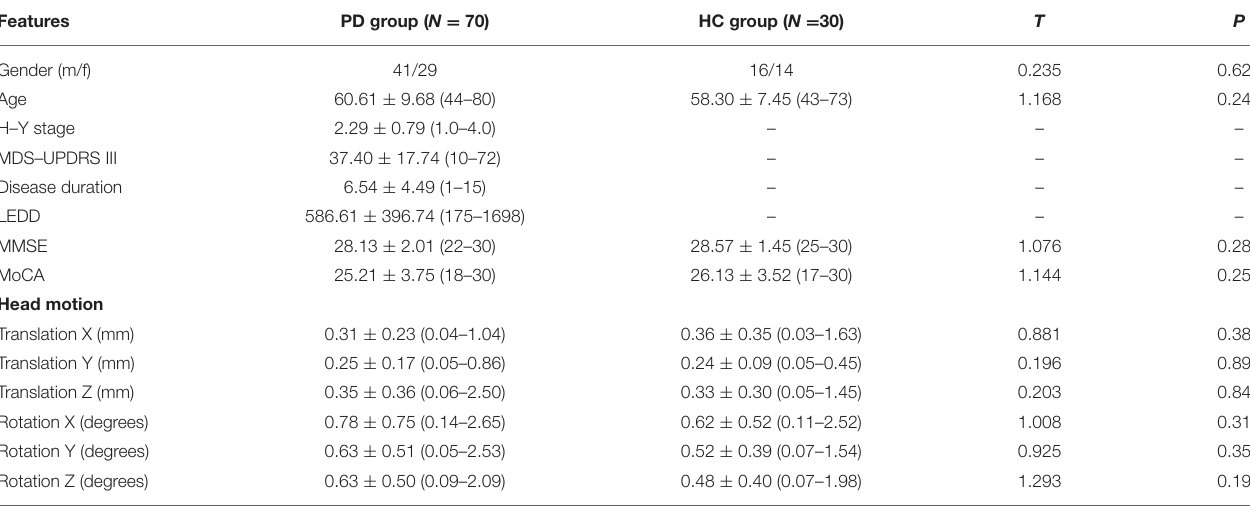
TABLE 1 | Demographics and clinical features of